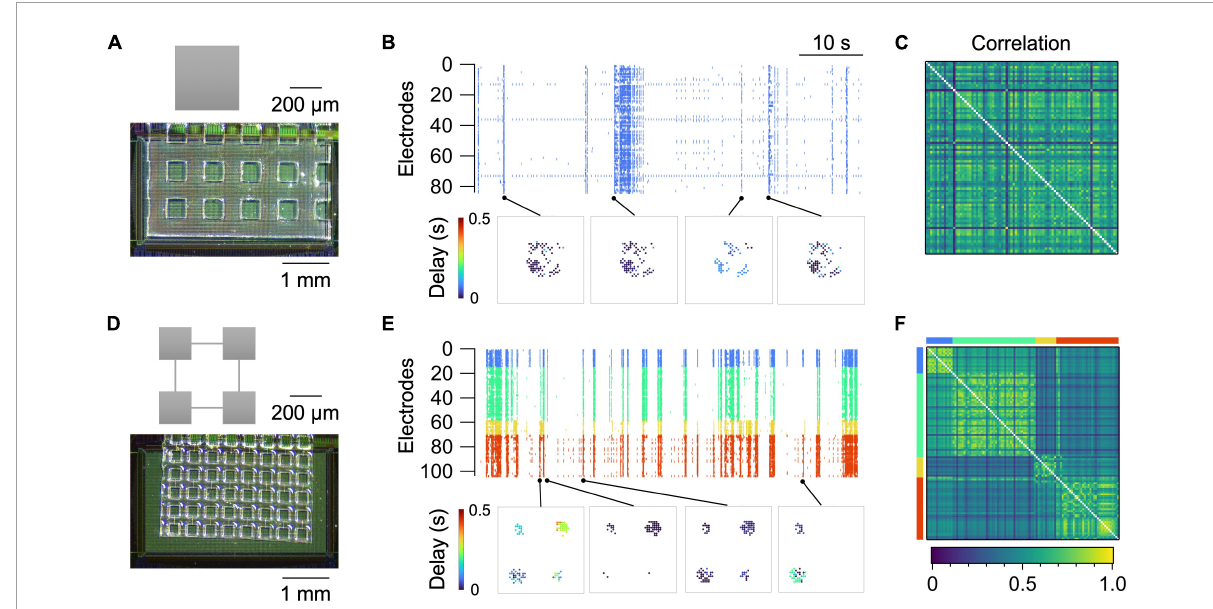
FIGURE3 Spontaneous activity in random (A–C) and modular (D–F) networks at 14 DIV. (A,D) Micropattern geometry and a micrograph of the PDMS microfluidic film placed on the sensing electrode area of the HD-MEA chip. (B,E) Raster plot (top) and representative propagation maps (bottom). A propagation map for a given network burst was generated by setting a marker at the position of electrodes that were active during the burst and coloring the markers based on the time delay from the onset of the burst. (C,F) Correlation coefficient matrix. For the modular network, electrodes belonging to separate modules are assigned different colors in (E,F)